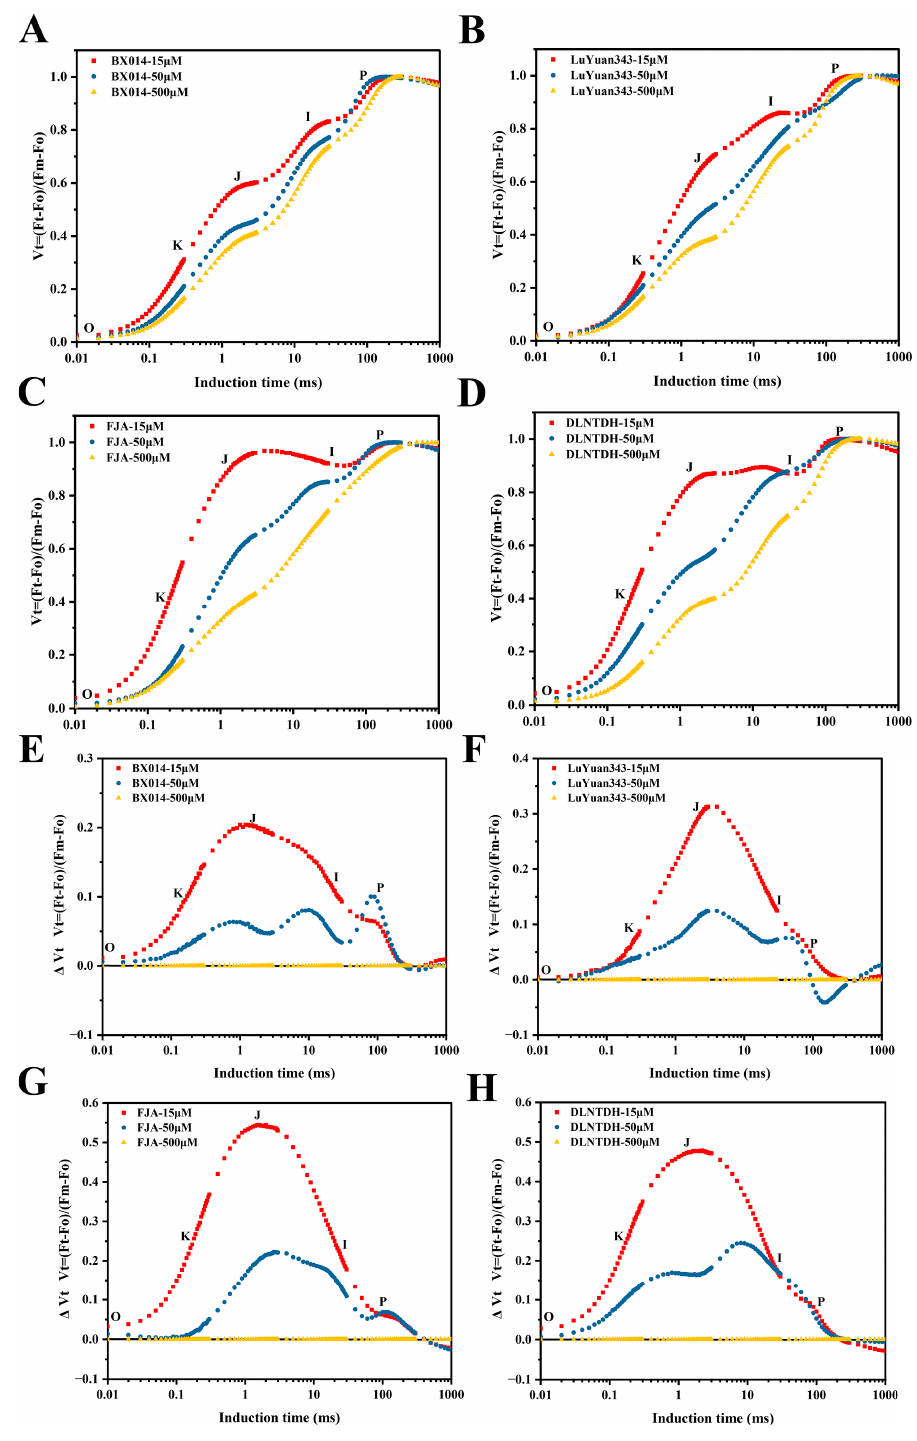
Figure 6. Variations in OJIP-kinetics ChlF rise of cotton leaves after different P treatment. (( A ) BX014, ( B ) LuYuan343, ( C ) FJA, and ( D ) DLNTDH, Vt = (Ft − F0)/(Fm − F0)), and the comparative variations of ChlF (( E ) (BX014), ( F ) (LuYuan343), ( G ) FJA, and ( H ) DLNTDH, ∆ Vt = Vt (treatments of 15 µ M and 50 µ M) − Vt (treatments of 500 µ M) in each genotype), third row of leaves, fully developed. Each curve represents the seven replicate averages.